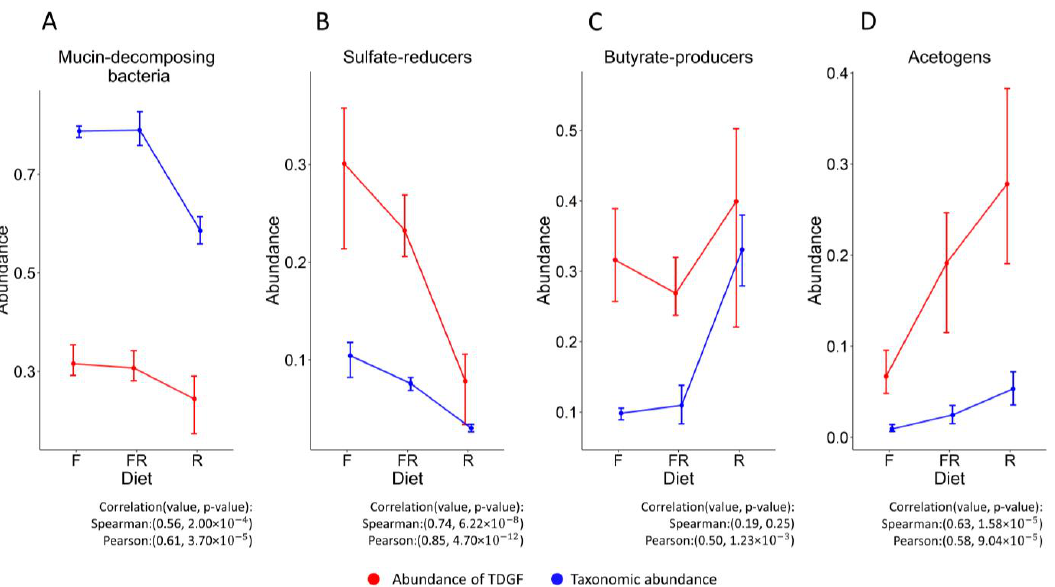
Figure 3. Comparison of TPM values calculated based on RNA-seq data and relative abundance of functional groups based on 16S rRNA data adapted according to the Formulas (3) and (4). F – fiber-